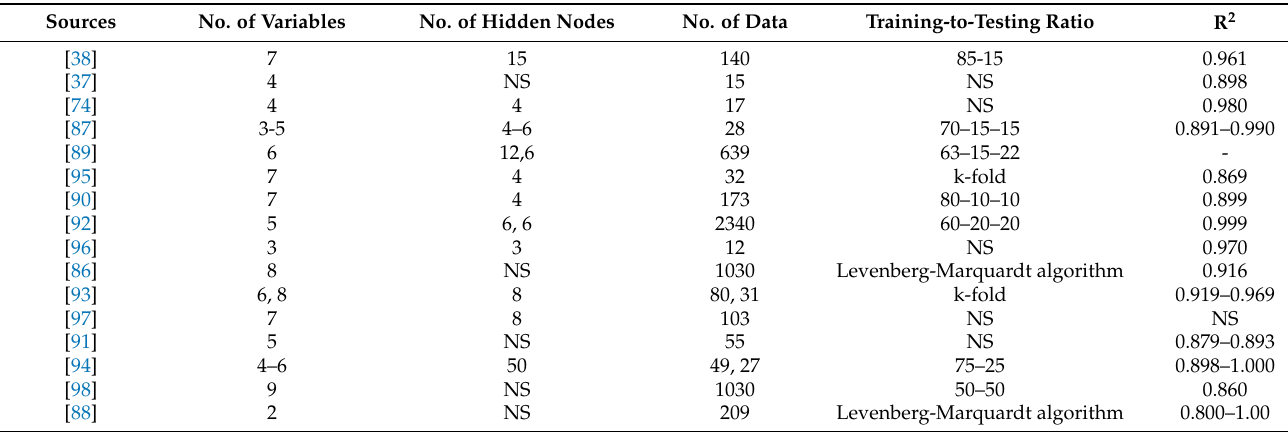
Table 9. Summary of ANNs